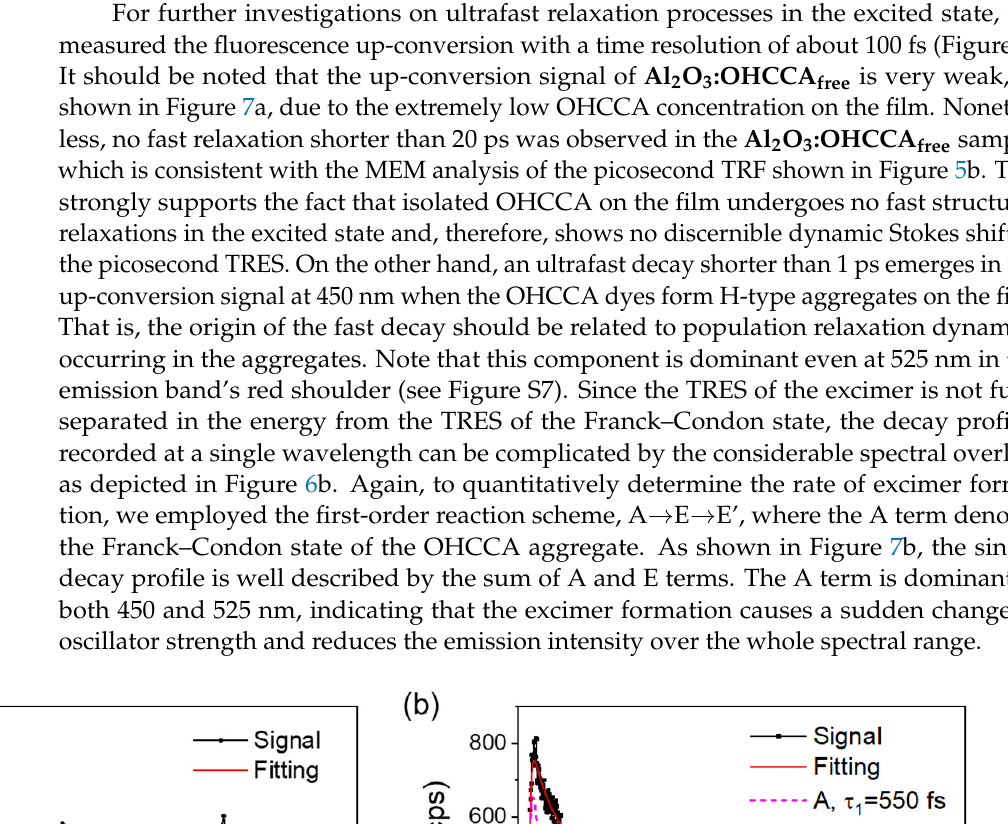
8 of 12 Figure 6. ( a ) Time-resolved area normalized emission spectra (TRANES) of Al 2 O 3 :OHCCA agg at se- lected times and ( b ) Evolution associated spectra (EAS) obtained from the global analysis. The inset of ( b ) shows the reaction path and associated time constants. A red open circle with a plus sign in ( a ) indicates the iso-emissive point of TRANES.